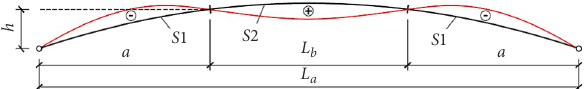
Figure 4. A diagram of the bending moments of the arch under permanent